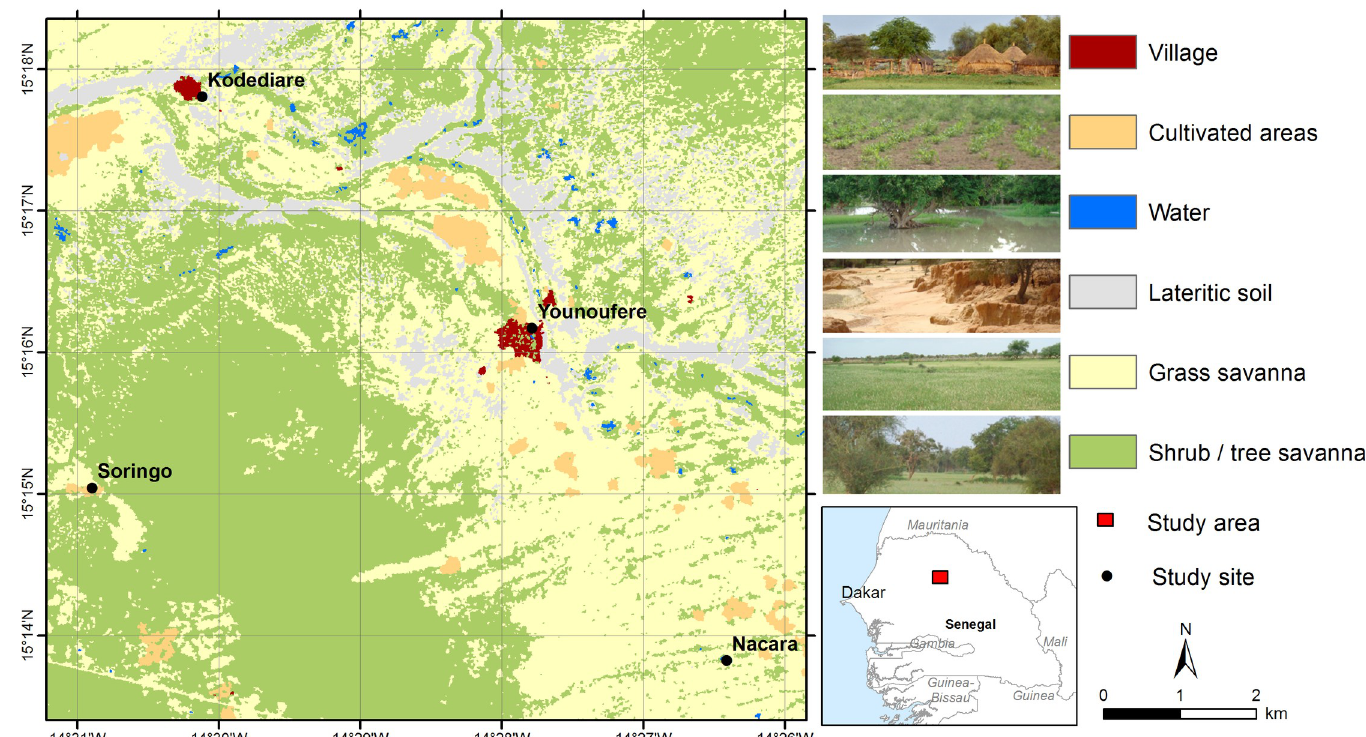
Fig 1. Map of the study area. Map created using ESRI ArcGIS; land cover map derived from a SPOT-5 image (2014-08-07); administrative boundaries extracted from DIVA-GIS (https://www.diva-gis.org/).